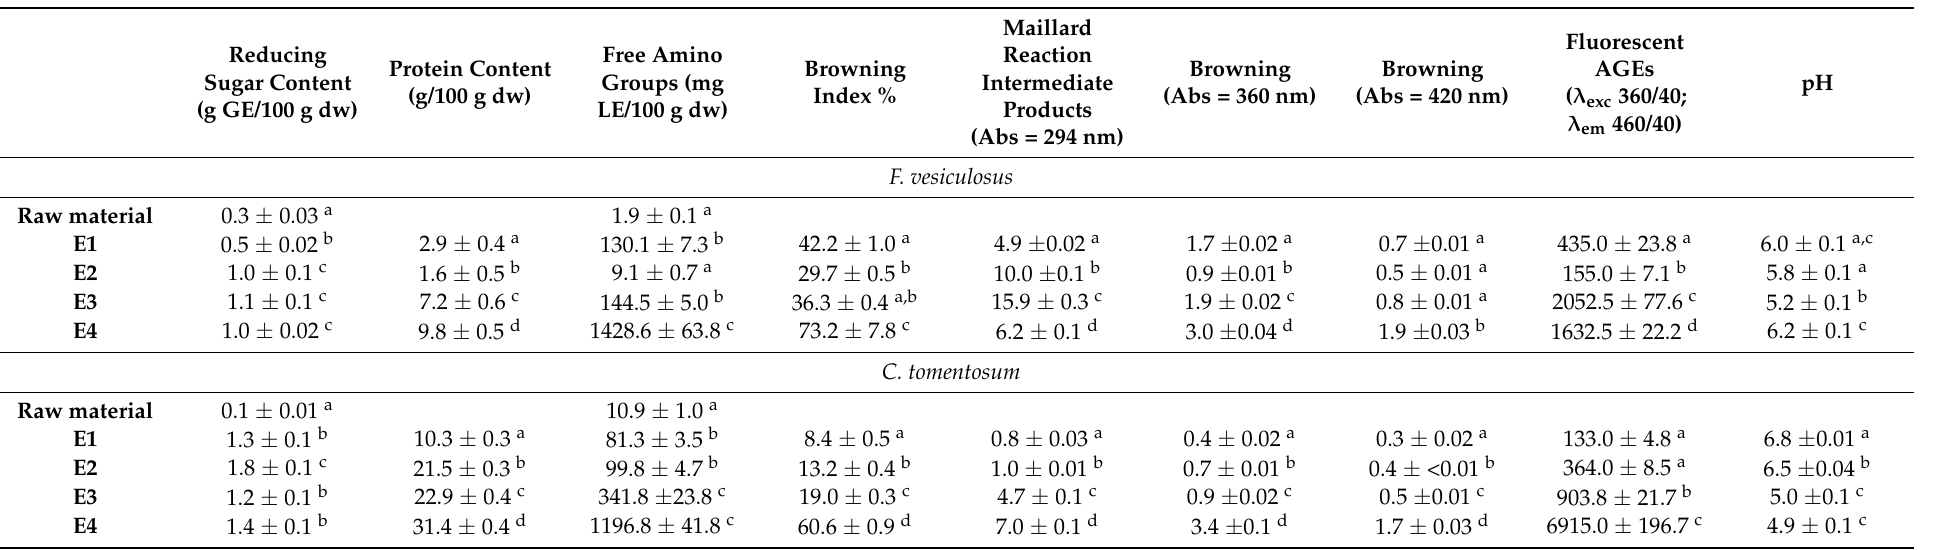
Table 5. Reducing sugar, total protein, free amino groups and Maillard reaction products of seaweeds and SWE extracts (mean ±